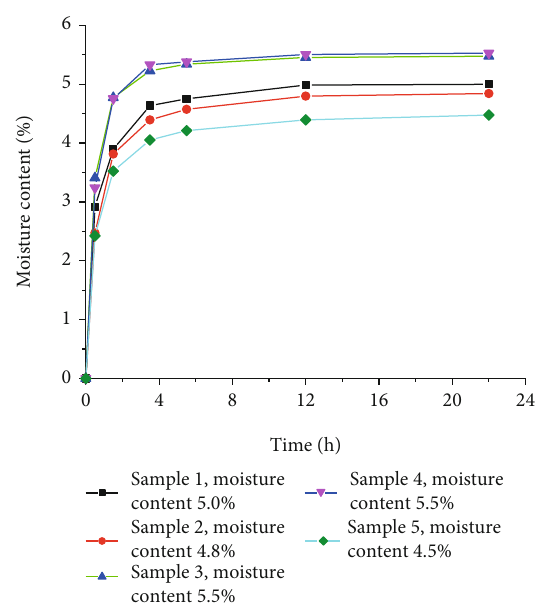
Figure 2: Saturation curves of rock